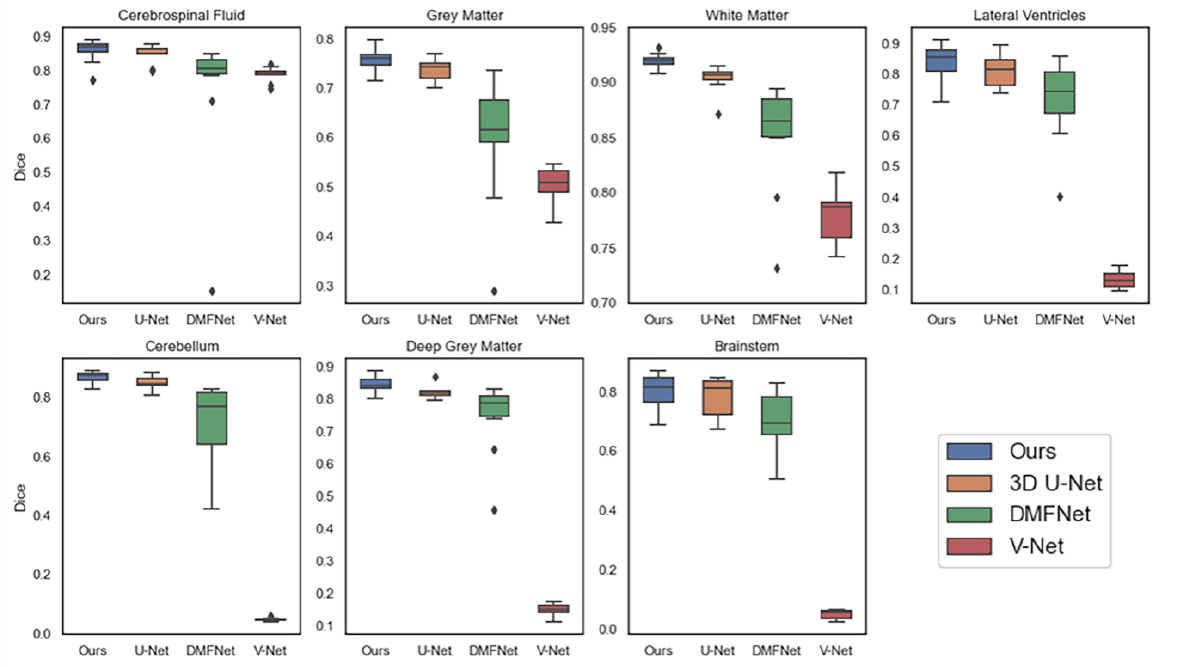
Figure 5. Analysis of dice values of four different methods (Ours, 3DU-Net, DMFNet and V-Net) on seven tissues. The rhomb indicates the abnormal value.